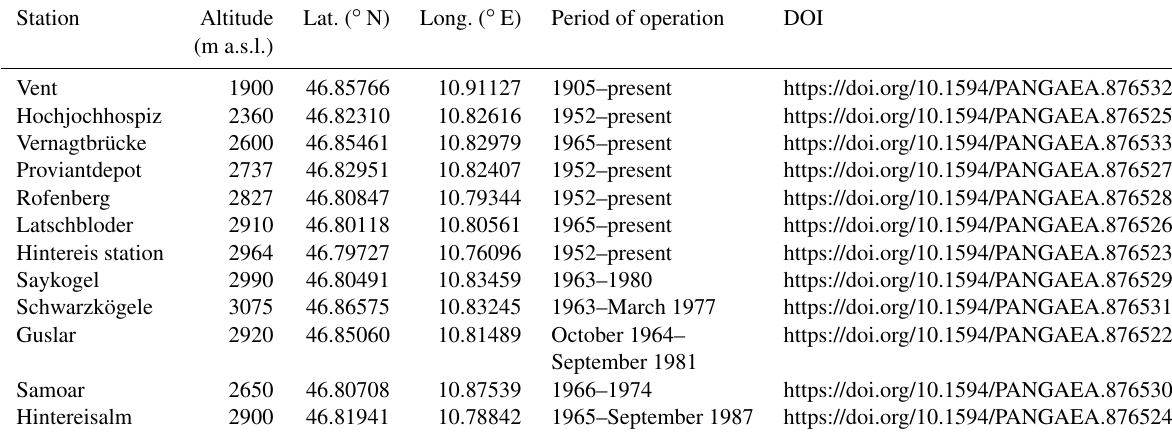
Table 4. Totalizing rain gauges in the Rofental. Station Altitude